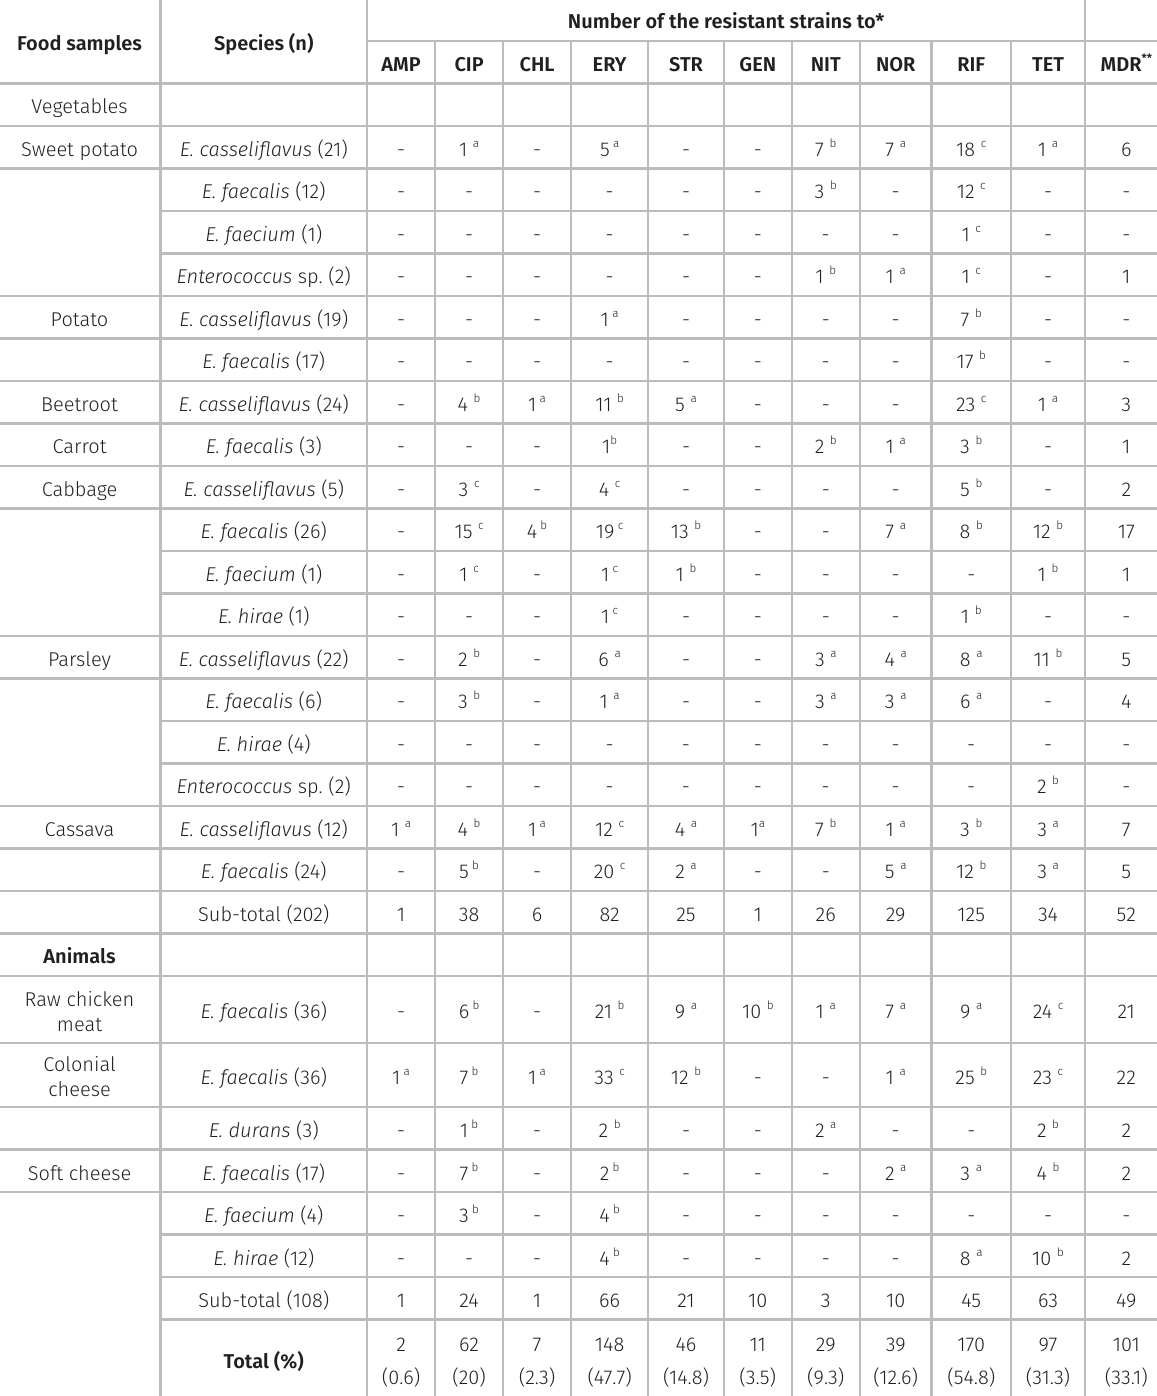
Table IV. Antimicrobial resistance profiles among enterococci isolated from different type of food. Food samples Vegetables Sweet potato